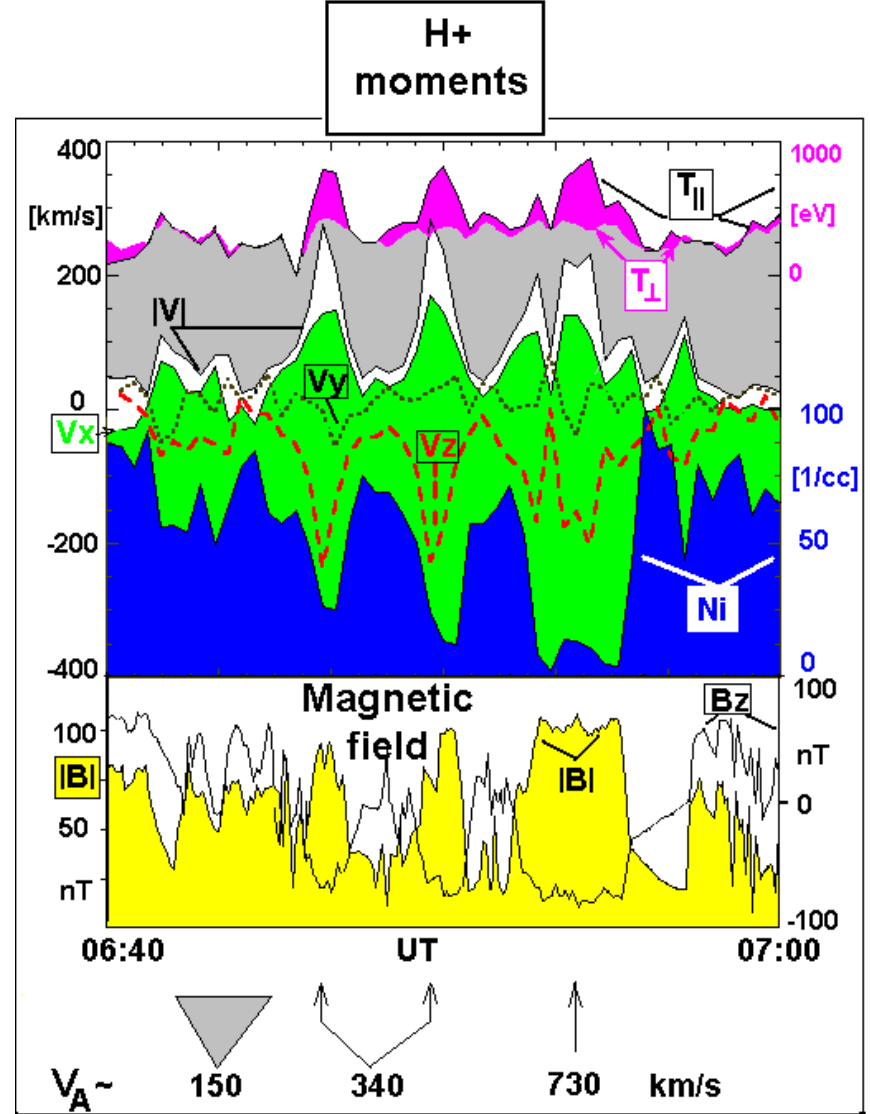
Fig. 6. Coherent structure in the inbound TBL from Polar (see Plates B1, B3, B5). Top panel: TIMAS proton moments – tempera- ture (violet shading depicts the difference between the parallel and perpendicular temperatures), velocity ( V x – green shading, V y – dots, V z – red dashed line) and density (blue shading). Bottom panel: magnetic field B z (the scale at the right) and | B | (yellow shading, the scale at the left). Bottom line: Alfv´en velocity in the MSH (gray triangle) and inside high-speed jets